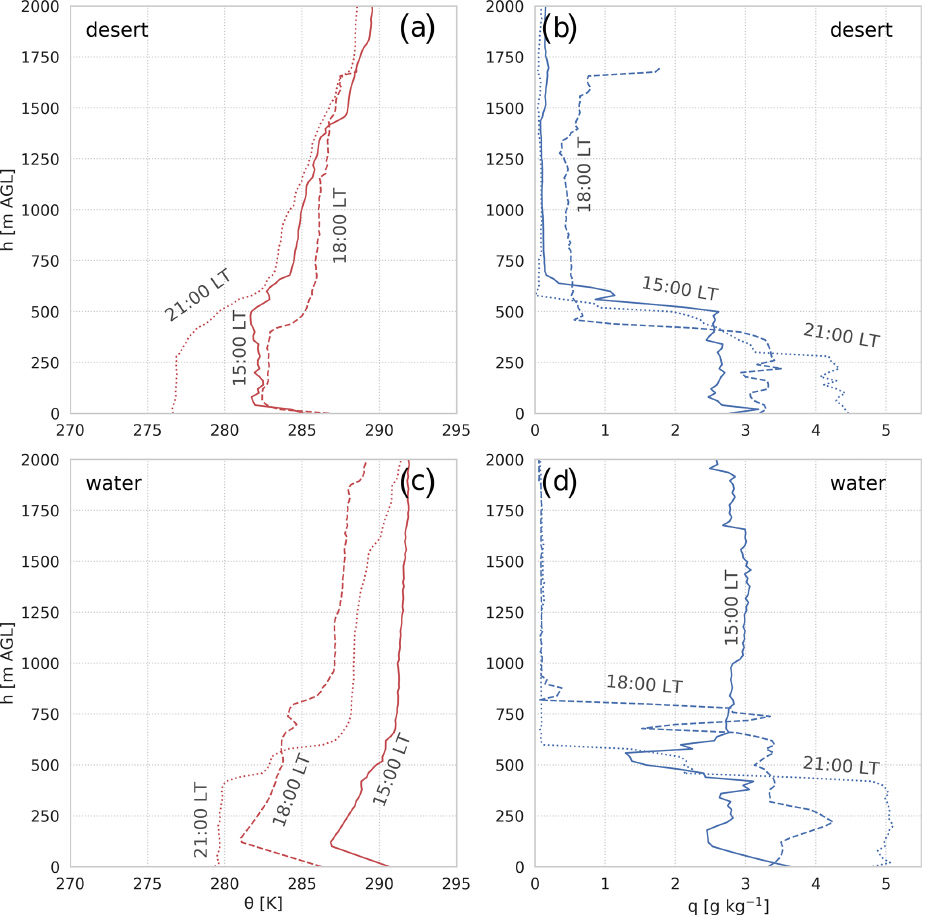
Figure 8. Afternoon vertical profiles of potential temperature ( θ ) and specific humidity ( q ) over the desert surface ( a and b ) for 20.35 ◦ S, 69.90 ◦ W at 3931ma . s . l . on 22 November 2018 and over the water surface ( c and d ) for 20.27 ◦ S, 68.88 ◦ W at 3790ma . s . l . on 21 November